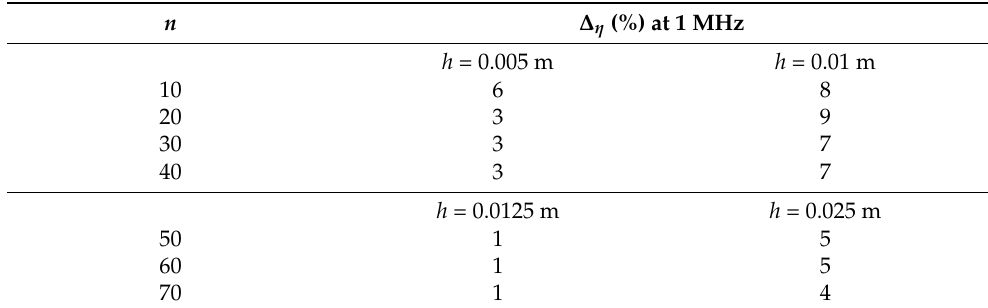
Table 7. Difference between the maximum values of η at 1 MHz for cases with and without skin effect. n ∆ η (%) at 1 MHz